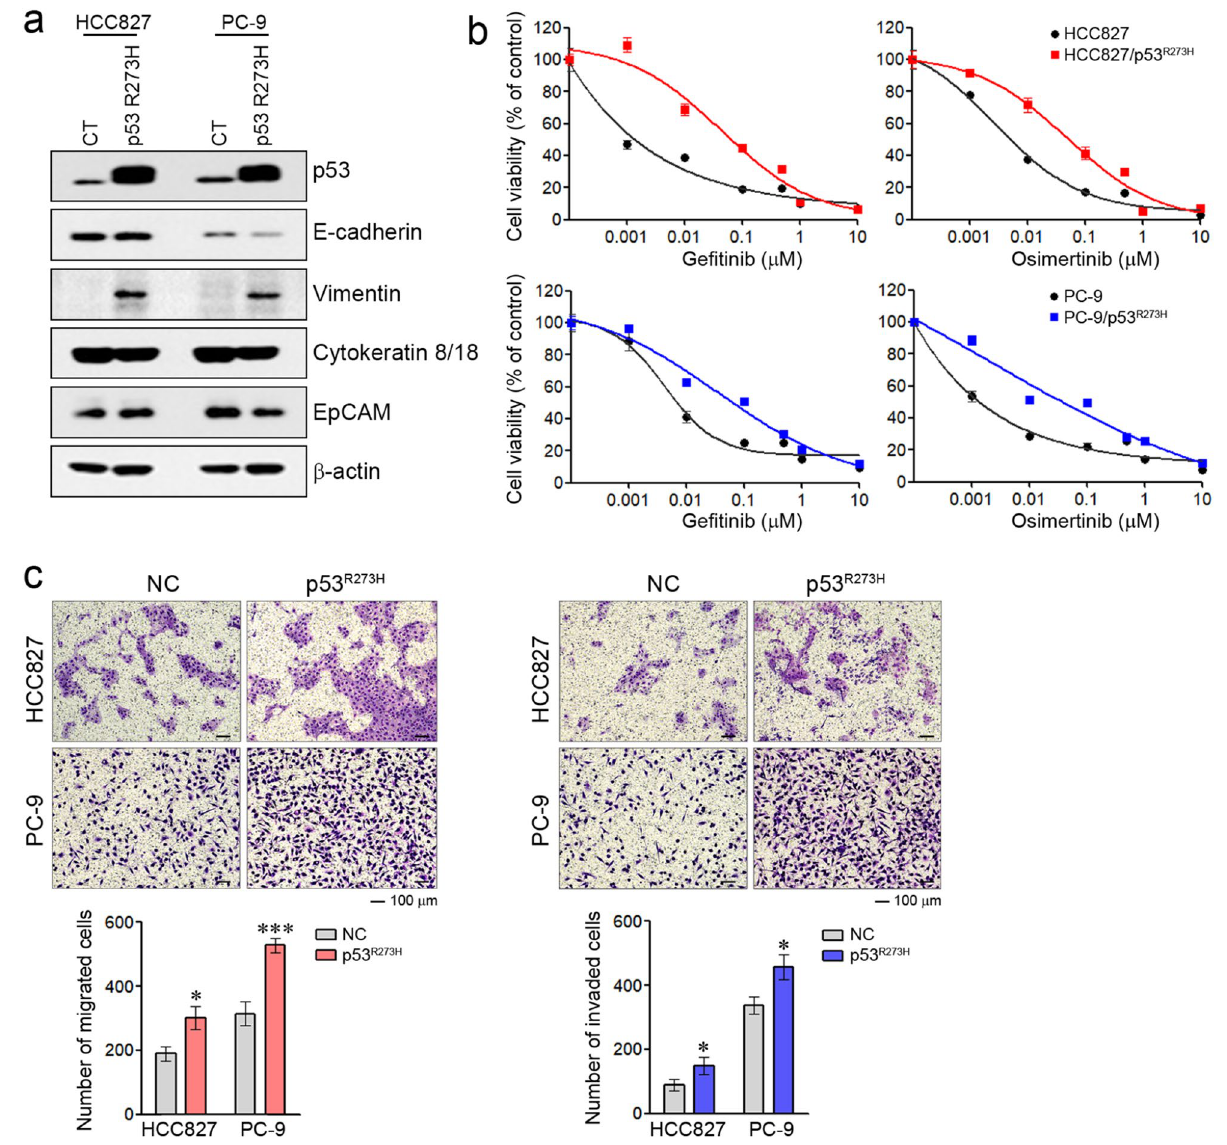
Figure 4. The effects of p53-R273H on sensitivity to EGFR-TKIs in NSCLC cells with activating EGFR mutations. Mutant p53-R273H was introduced into cells with activating EGFR mutations. ( a ) p53 and EMT- related protein levels were analyzed by immunoblotting. ( b ) Cells were treated with the indicated doses of gefitinib or osimertinib for 72 h, and cell viability was determined using MTT assays. ( c ) Cells were seeded onto either collagen- or Matrigel-coated polycarbonate filters to determine their migratory and invasive potentials, respectively. Cells were incubated in modified Boyden chambers for 24 h, and the cells that penetrated the filter were stained and counted using a light microscope. Experiments were conducted in triplicate. * p < 0.05; *** p < 0.0005 compared with